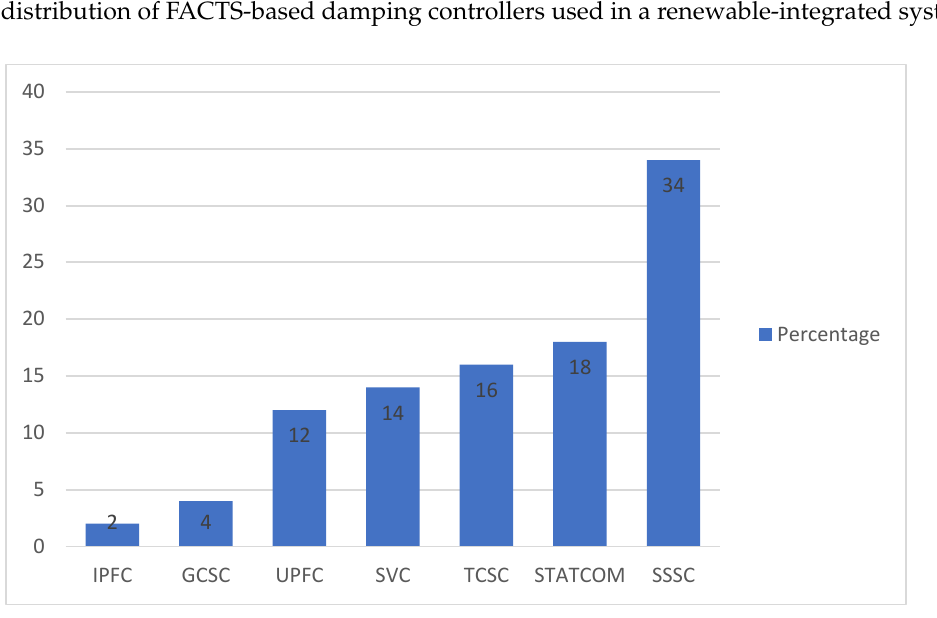
Figure 17. FACTS utilized damping controllers in a renewable grid-integrated system based on publications.